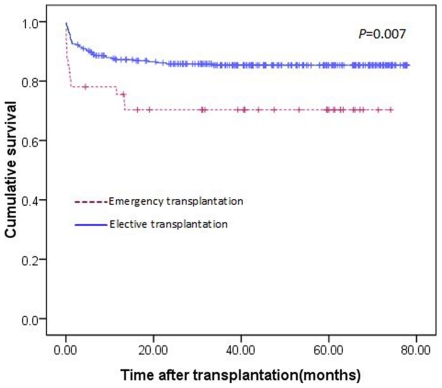
Survival curve of patients undergoing emergency liver transplantation versus elective liver transplantation (P = 0.007).